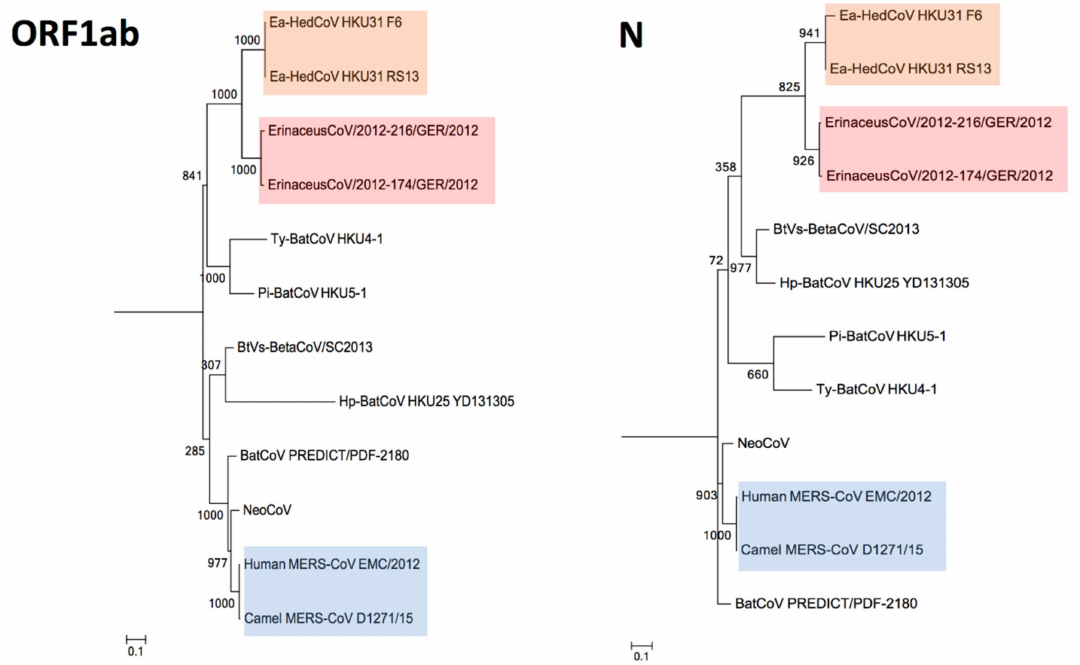
Figure 5. Phylogenetic analyses of ORF1ab and N amino acid sequences of Ea -HedCoV HKU31 and other members of Merbecovirus . The maximum likelihood method was used to construct ORF1ab and N by using the LG + G + F substitution model. Bootstrap values were calculated from 1000 trees. Corresponding sequences of HCoV HKU1 were included for trees rooting (GenBank accession number NC_006577). All bootstrap values are shown. The scale bars represent 10 substitutions per site in ORF1ab and N trees respectively. Human and camel MERS-CoVs are highlighted in blue. The two Erinaceus betacoronaviruses from Europe are highlighted in red. The two Ea -HedCoV HKU31 strains, F6 and RS13, detected in this study are highlighted in